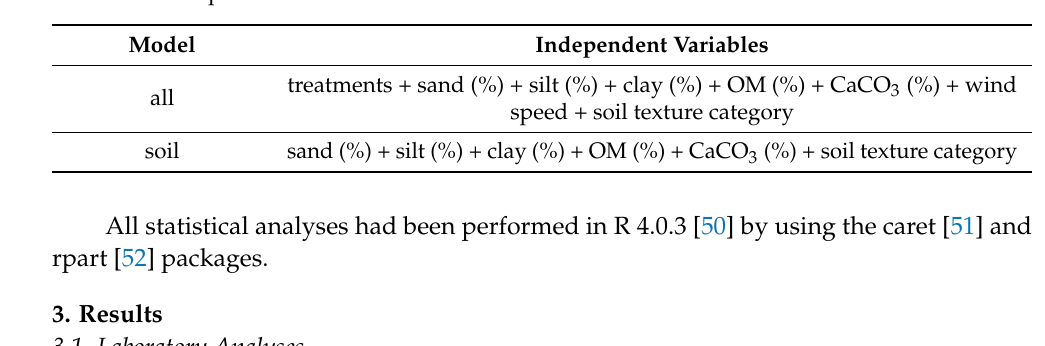
Table 1. Independent variables for the random forest regression (RFR) models, where the evaporation time was the dependent variable.